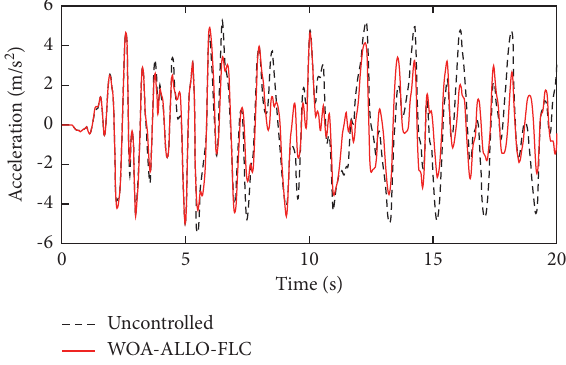
Figure 10: The top floor acceleration responses of Building 1.